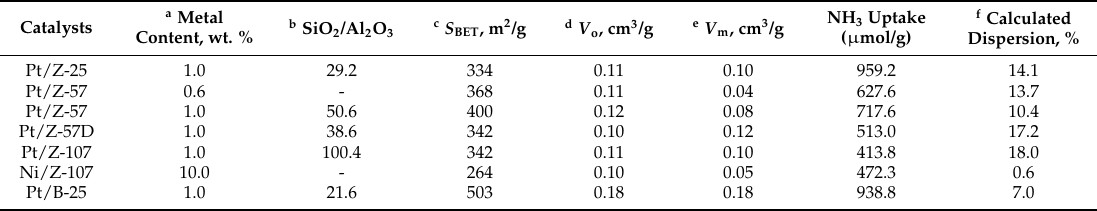
Table 5. Chemical composition, textural properties, NH 3 uptake, and calculated dispersion of the catalysts.